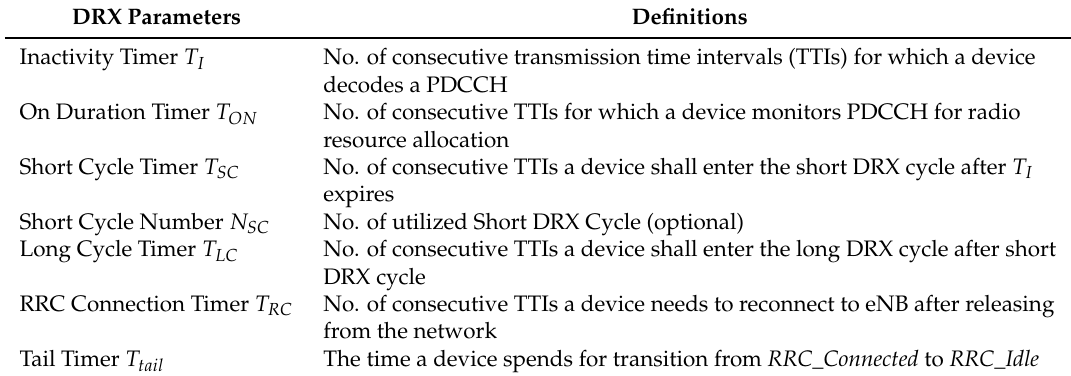
Table 1. List of various DRX parameters with definitions